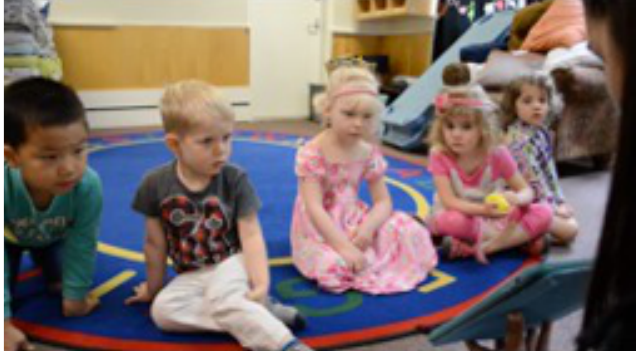
Figure 1. Participants reading an iPad story with the